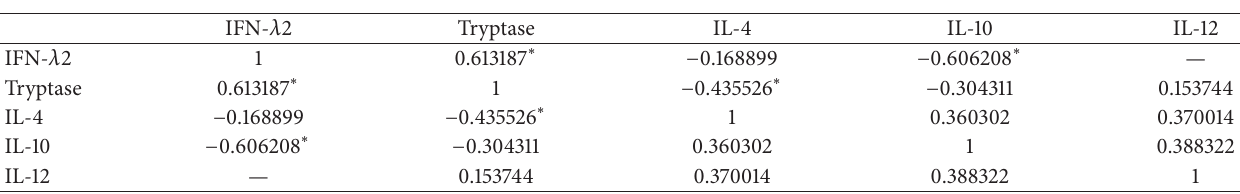
Table 2: Spearman’s Rho/correlation coefficient between the serous levels of IFN- 𝜆 2, tryptase, and other